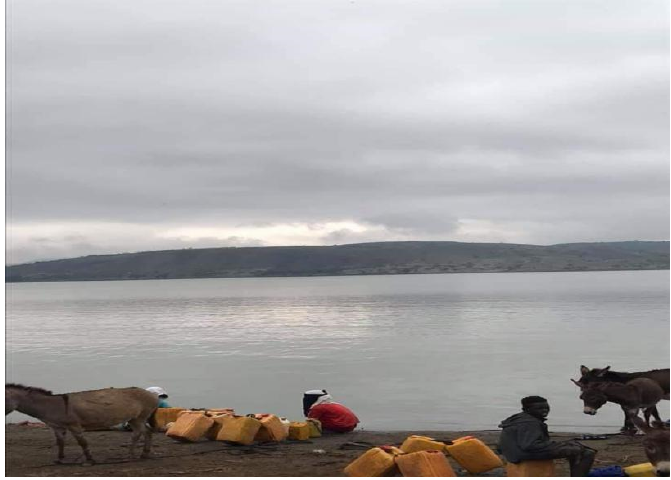
Figure 7. Lake Qooqa. Amudde. 27 January 2020. Photo Courtesy, Author.